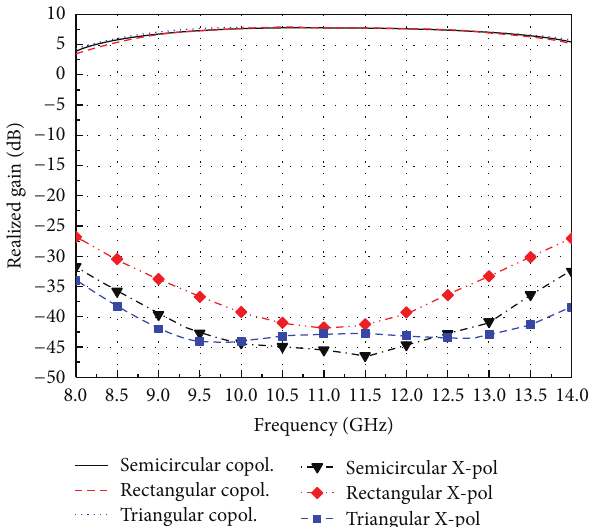
Figure 13: Return loss versus